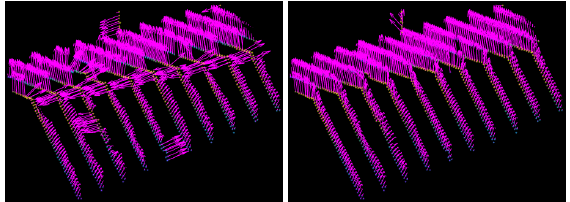
Figure 6. Normals of a roof of data set ALS-OSC. The selected house is marked by a green rectangle in Fig. 5. Left: k NN16, right: samp k NN16. Because of the large inhomogeneity poor normals will result for a standard k NN measuring distance, multi channel or multi strip coverage,